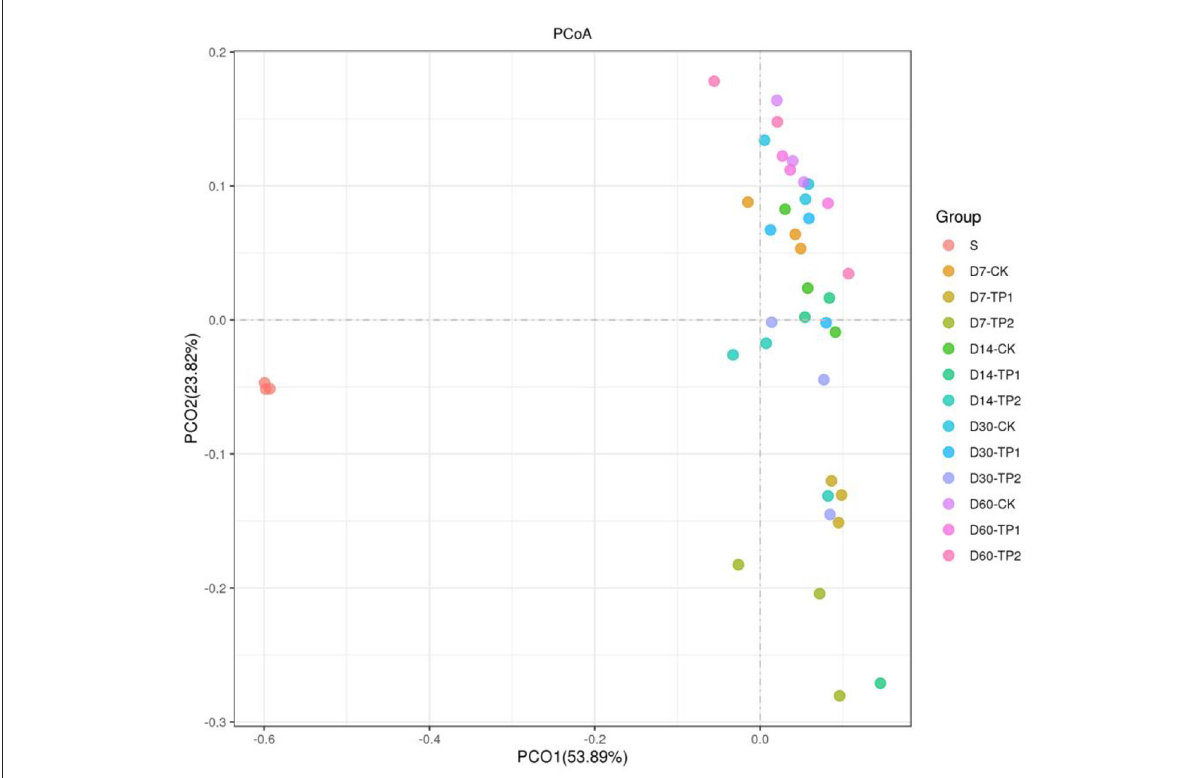
FIGURE1 Principal coordinates analysis ( PCoA, Weighted UniFrac) of bacterial community in the stylo silage ensiled with/without TPP addition (S: raw stylo; D7-CK: on day 7 of ensiling fermentation-blank control, silage ensiled without addition of tea polyphenols; TP1 and TP2: silage ensiled with addition of 0.2%, 0.4% tea polyphenols on a FM basis).